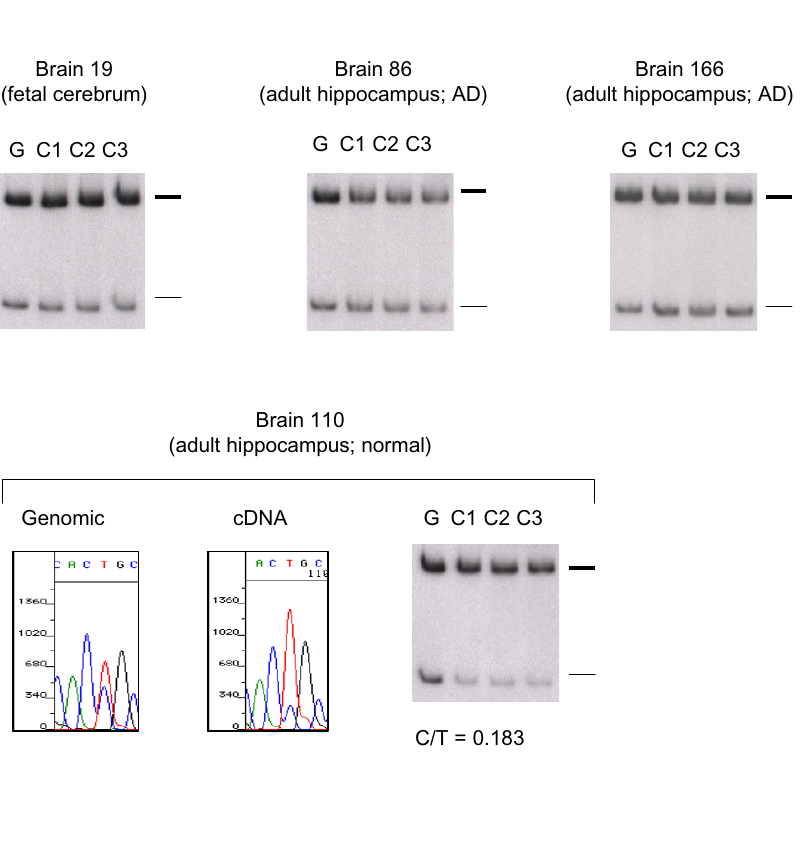
Figure 2 Allele-specific TP73 mRNA expression in human brains. In the Ban I RFLP autoradiograms the T-allele (uncut) is indi- cated by the thick marker line and the C-allele (cut) by the thin marker. Additional smaller fragments ran at a lower position and are not shown. The genomic PCR (G) is a control for equal biallelic representation. The RT-PCR in each case was repeated three times from independent aliquots of cDNA (C). Direct sequencing confirms the pronounced allelic expression bias (stronger upper band) in adult brain 110, with the genomic sequence chromatogram serving as a control for biallelic rep- resentation. Less pronounced but reproducible biases are seen among the other brains (weaker upper band in RT-PCR prod-